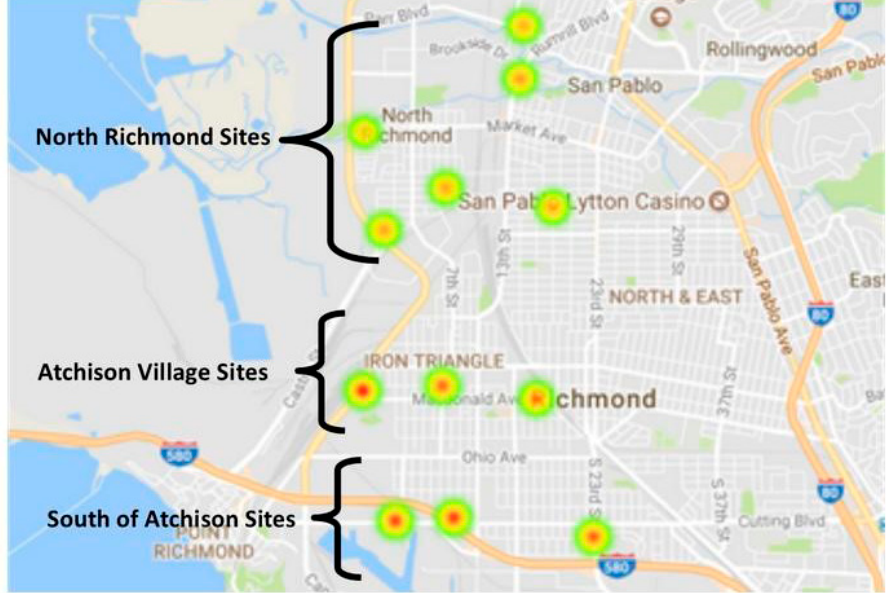
Figure 1. Map of sample sites for Atchison Village, South of Atchison (along I-580), and North Richmond. Darker red colors of sample sites indicate higher NO 2 concentrations.